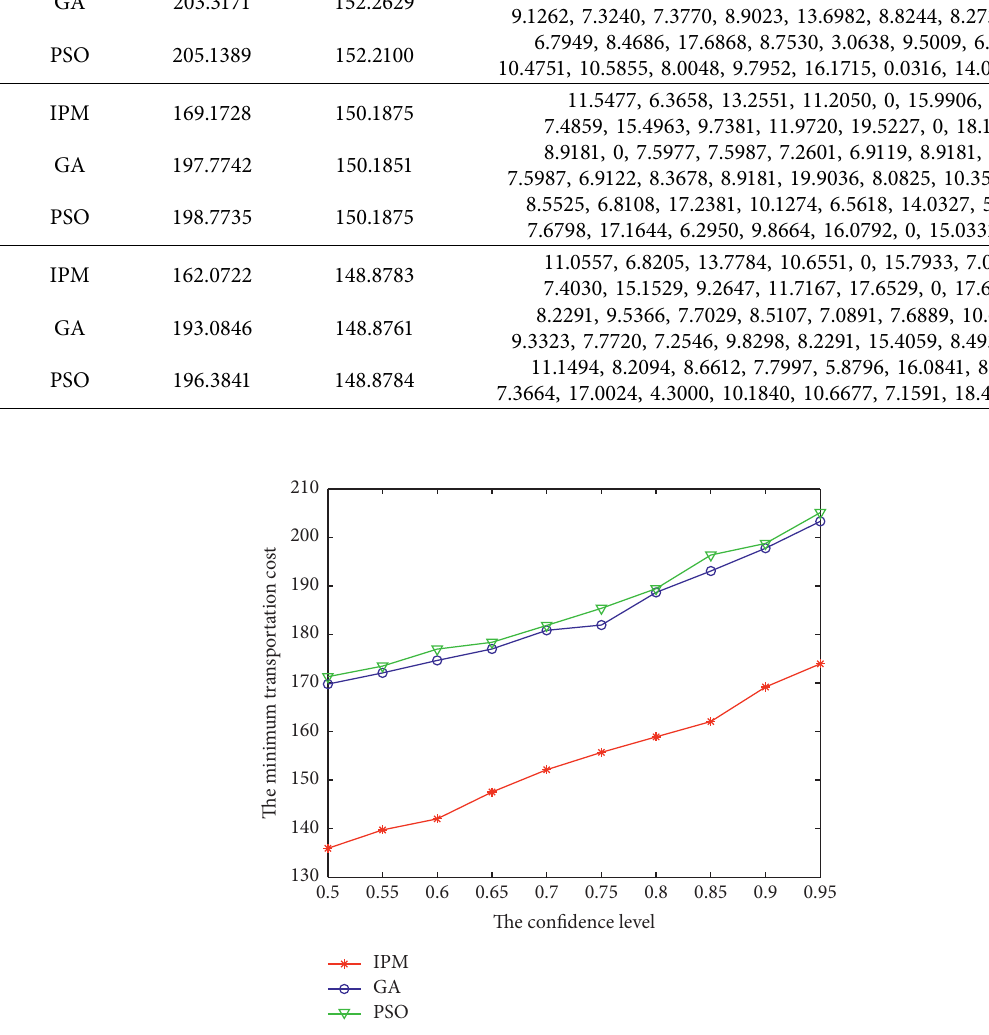
Figure 5: Sensitivity analysis of the chance-constrained